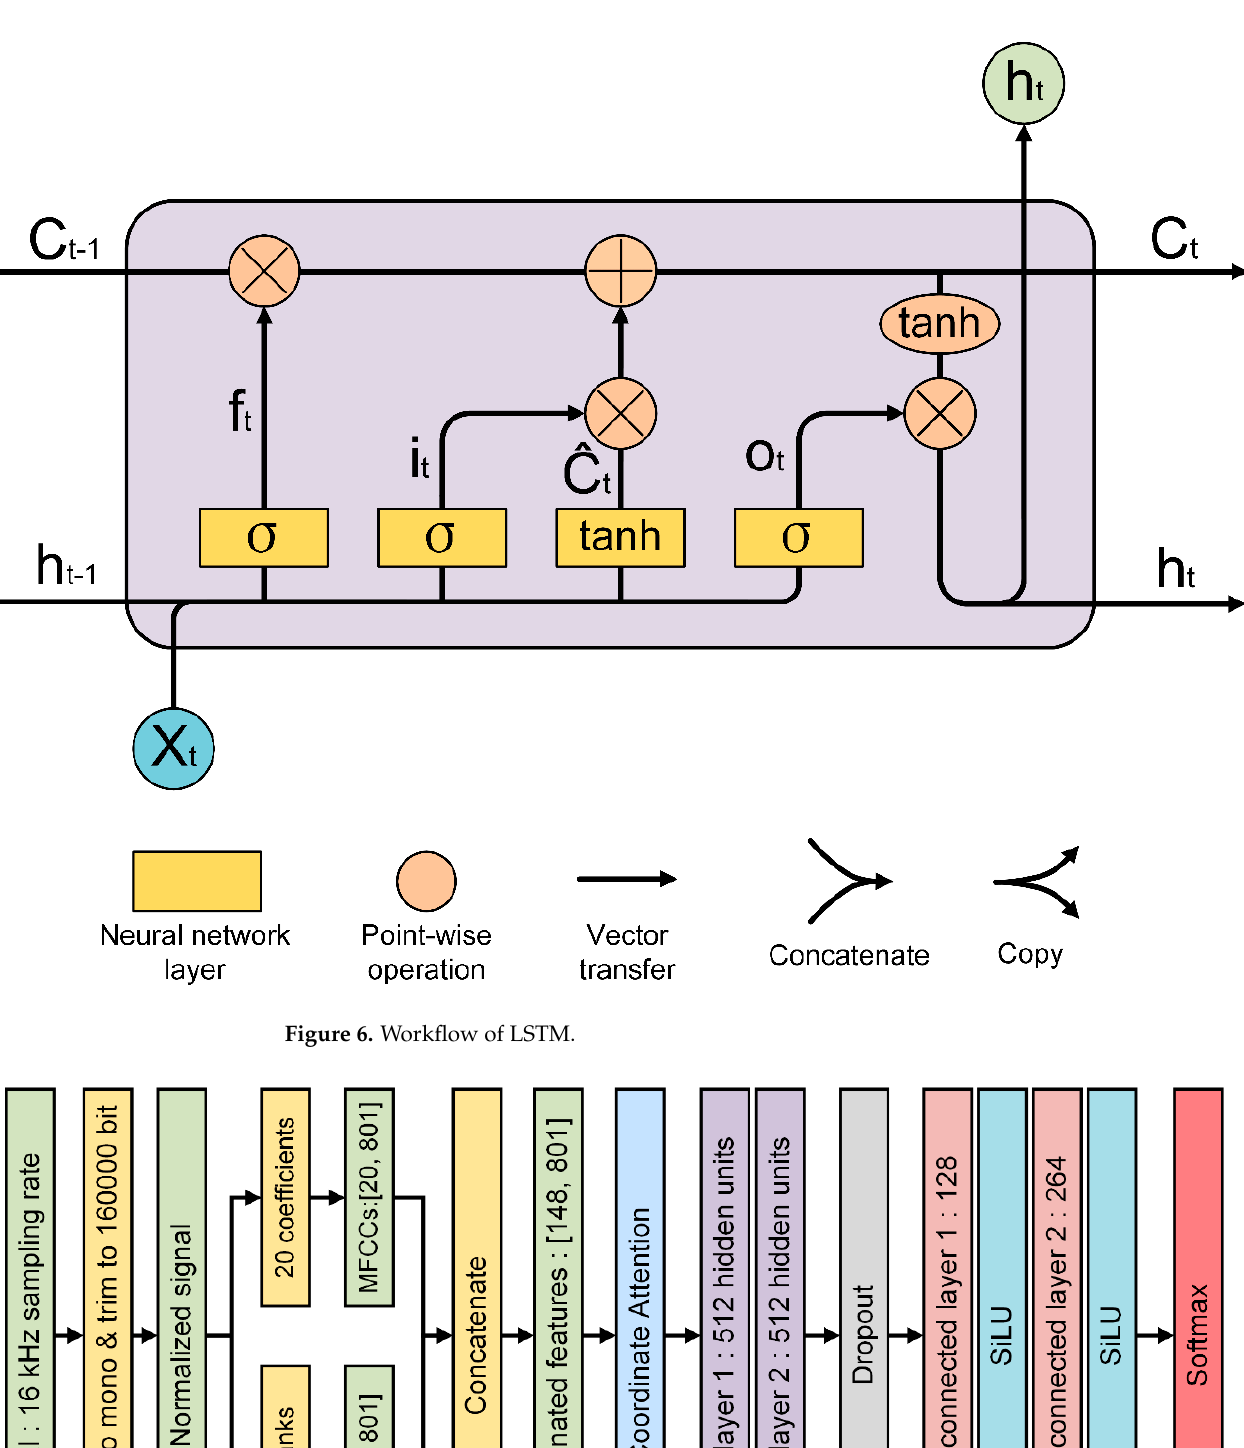
Figure 5. Process of bird species identification.